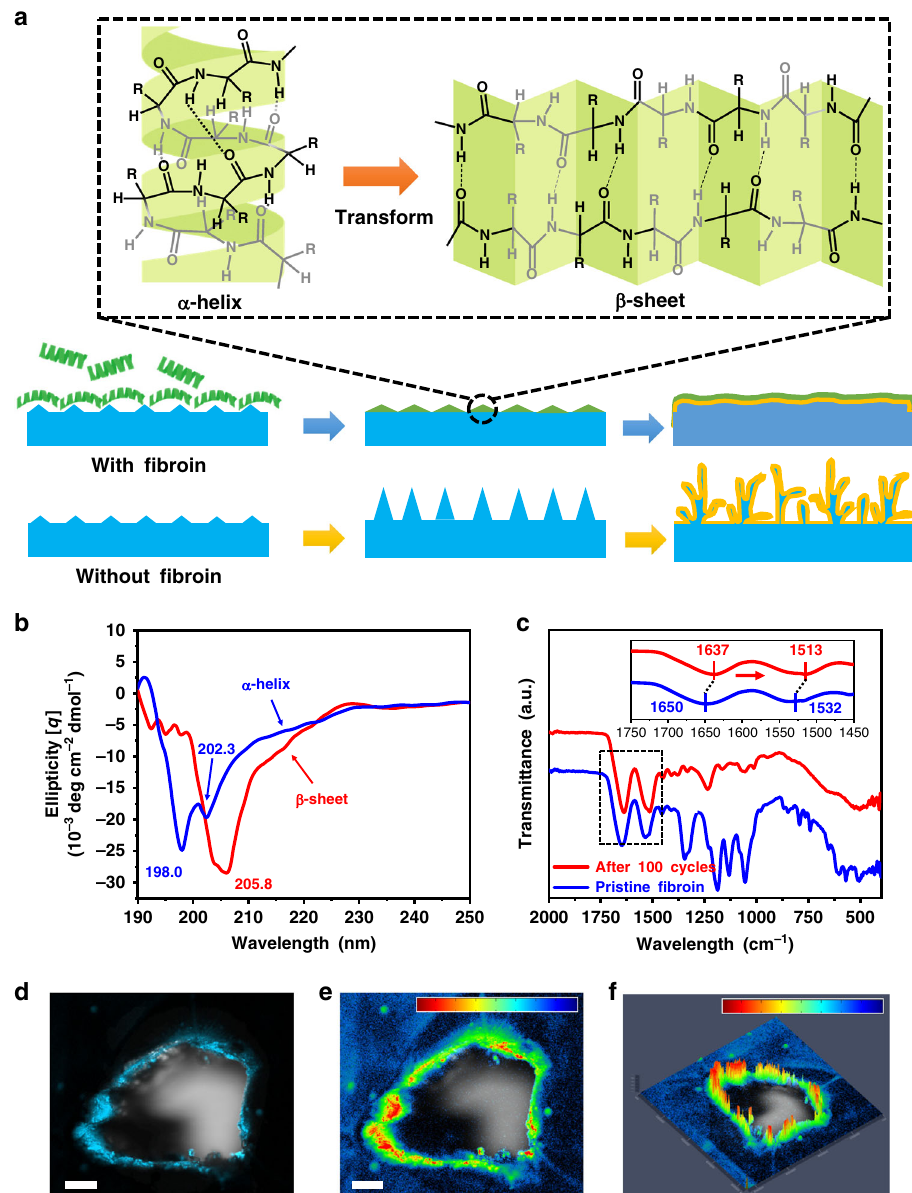
Fig. 1 Schematic diagram of the self-defense mechanism of fi broin. a Illustration of the secondary structural transformation of fi broin molecules and the self-defense mechanism of immunizing Li metal anode against Li dendrite growth. ( “ R ” groups are known as side chains of amino acids (-H to Glycine residue, – CH 2 OH to Serine residue, and – CH 3 to Alanine residue)). b , c CD spectra ( b ) and ATR-FT-IR spectra ( c ) of pristine fi broin and recovered fi broin from the cycled cell after 100 cycles. d A fl uorescent image of fi broin molecule distribution around the edges and protrusions on a Li metal foil under UV- light. e , f The corresponding 2D ( e ) and 2.5 D ( f ) simulations of fl uorescence intensity. The scale bars on the top in ( e ) and ( f ) correspond to the intensity increase from blue to red. Scale bars, ( d , e ) 100 µ con fi rmed that the transformation of the protein secondary structure is not triggered by electrolyte and Li + . According to the previous report 16 , the spatial conformation and high af fi nity of peptide bonds in fi broin molecules can drive fi broin secondary structure change. When protein molecules with the α - helix secondary structure interact with a Li metal surface, the ‒ NH and C = O functional groups of the peptide bonds show a strong af fi nity with the Li metal anode, triggering the irreversible conformation change from α -helix (high energy) to β -sheet (low energy). Once the initial layers of fi broin molecules conformably bind to the Li metal surface, the adsorption of further protein molecules can be signi fi cantly enhanced owing to cooperative